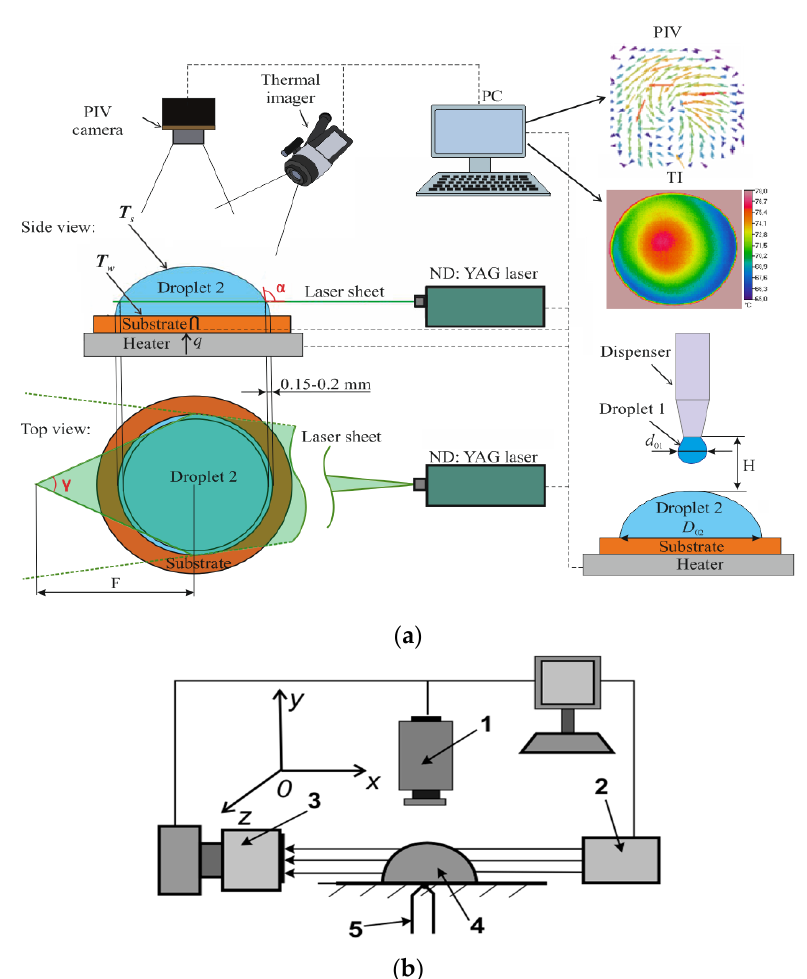
Figure 1. ( a ) Scheme of measuring T s and the instantaneous velocity field inside drop 2 using PIV. PIV—Particle Image Velocimetry; TI—Thermal Imager. ( b ) The measurement scheme of drop 2 static contact angle: (1) the video camera; (2) the source of plane-parallel light; (3) the camera Nikon D750 (with micro lens); (4) drop 2; (5) a thermocouple for measuring the wall temperature ( T w ).